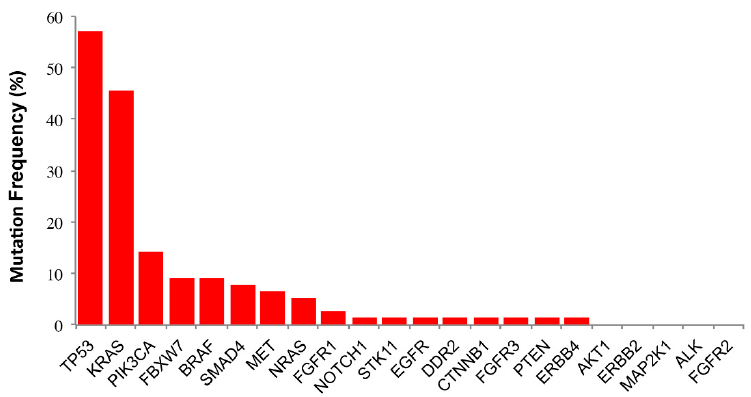
Figure 1. Mutation frequency for each gene of the panel in the study cohort. Table 2. List of the genes carrying actionable mutations in the studied metastatic colorectal cancer (mCRC)